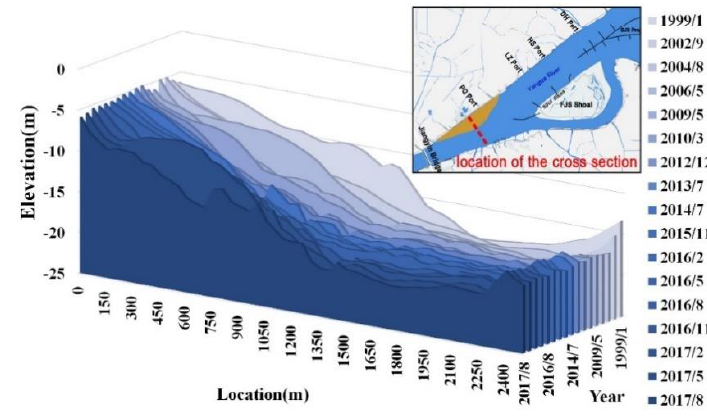
Figure 4. Shapes of the typical cross section with the maximum width of JJS based on the bathymetric dataset.